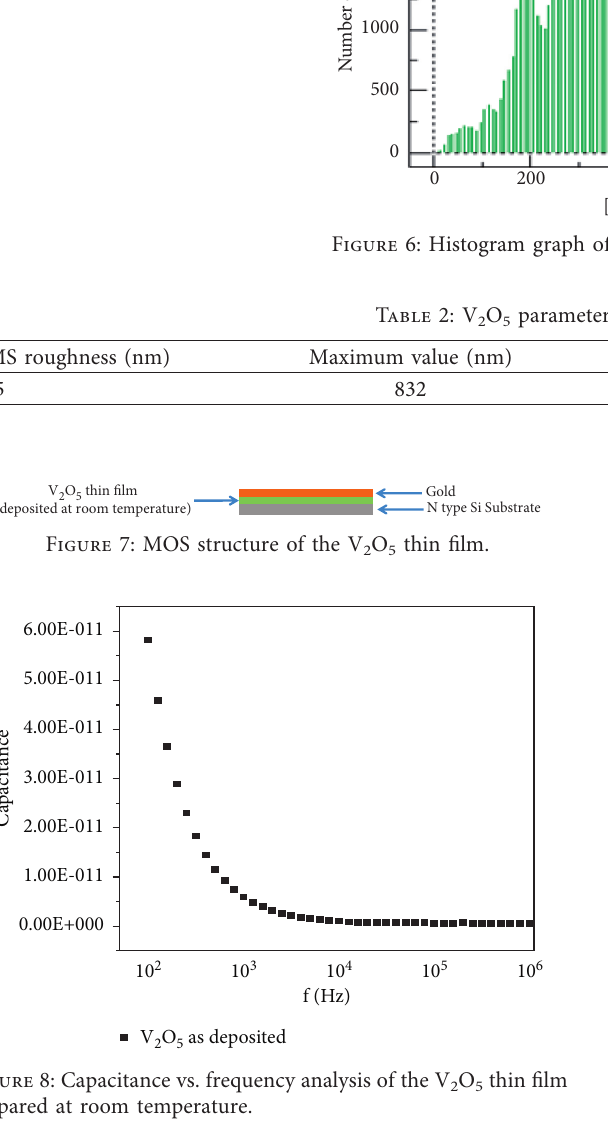
2 O 5 thin film